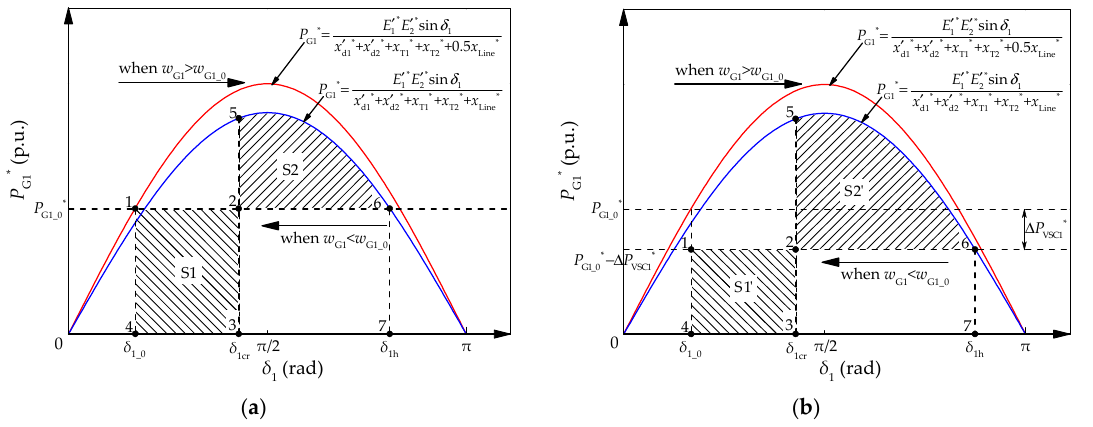
Figure A2. The acceleration area and the deceleration area. ( a ) Without the VSC-DC system. ( b ) With the VSC-DC system.